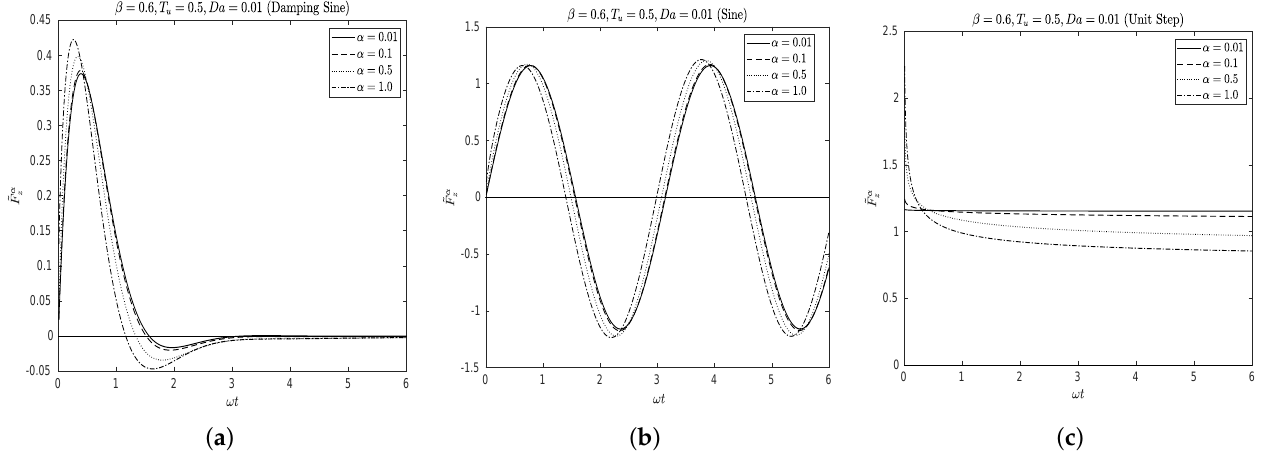
Figure 3. Variation of drag force for all three cases: ( a ) damping sine oscillation, ( b ) sine oscillation, ( c ) unit step function.